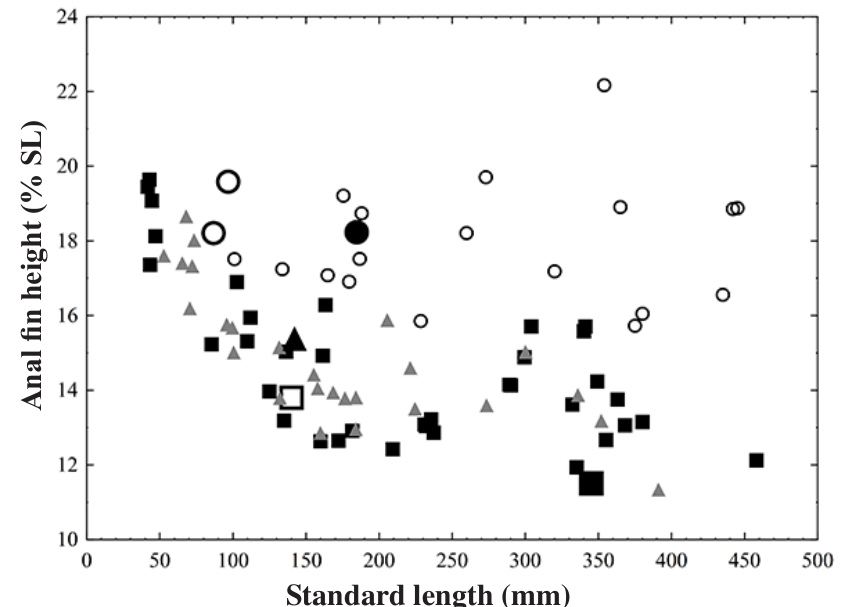
Fig. 4 . Scatterplot of anal fin length (% SL) vs SL (mm) of the witvis, sawfin and Clanwilliam yellowfish to show the consistently longer anal fin of the latter. Barbus andrewi : o = holotype; B. capensis : ¢ = holotype, n = specimens; B. serra : p = holotype, r = specimens; Labeobarbus seeberi : ¡ = lectotype and paralectotype, ¡ =